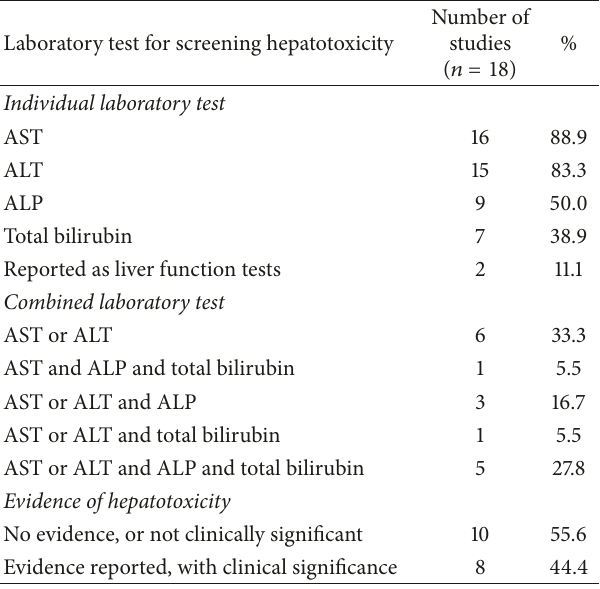
Table 2: Reported biochemistry markers and evidence of hepato- toxicity.